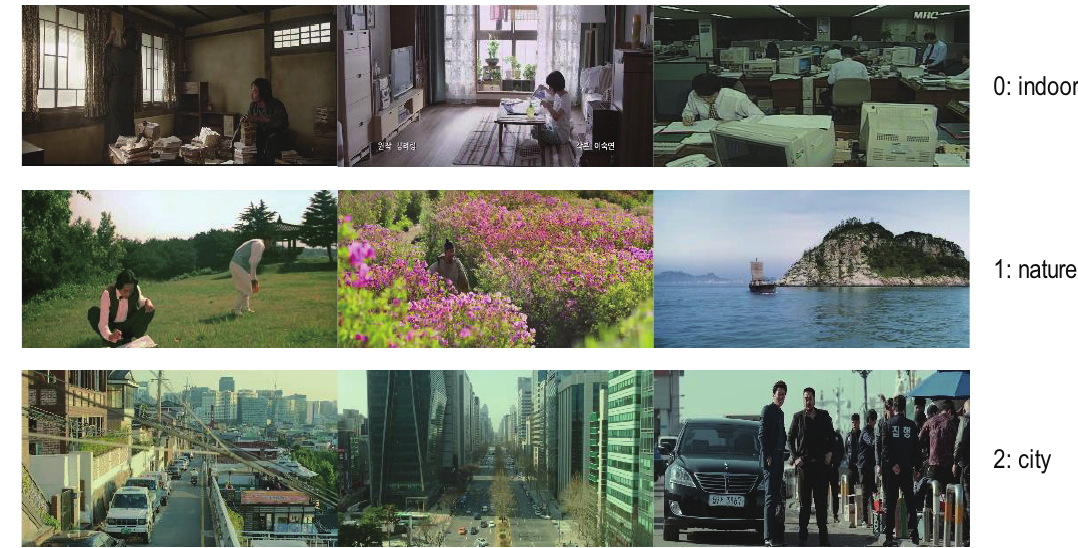
Figure 5. Samples of custom test dataset; each row represents each scene class.